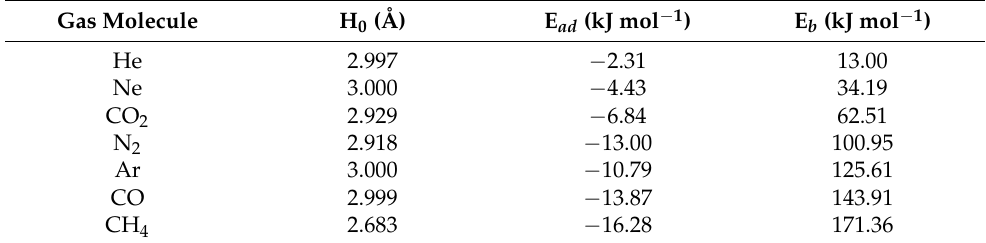
Table 2. The adsorption height (H 0 ), the corresponding adsorption energy (E ad ) between the gas molecule and the Ni-PTC monolayer, and the energy barriers (E b ) of the seven gas molecules translocating the Ni-PTC